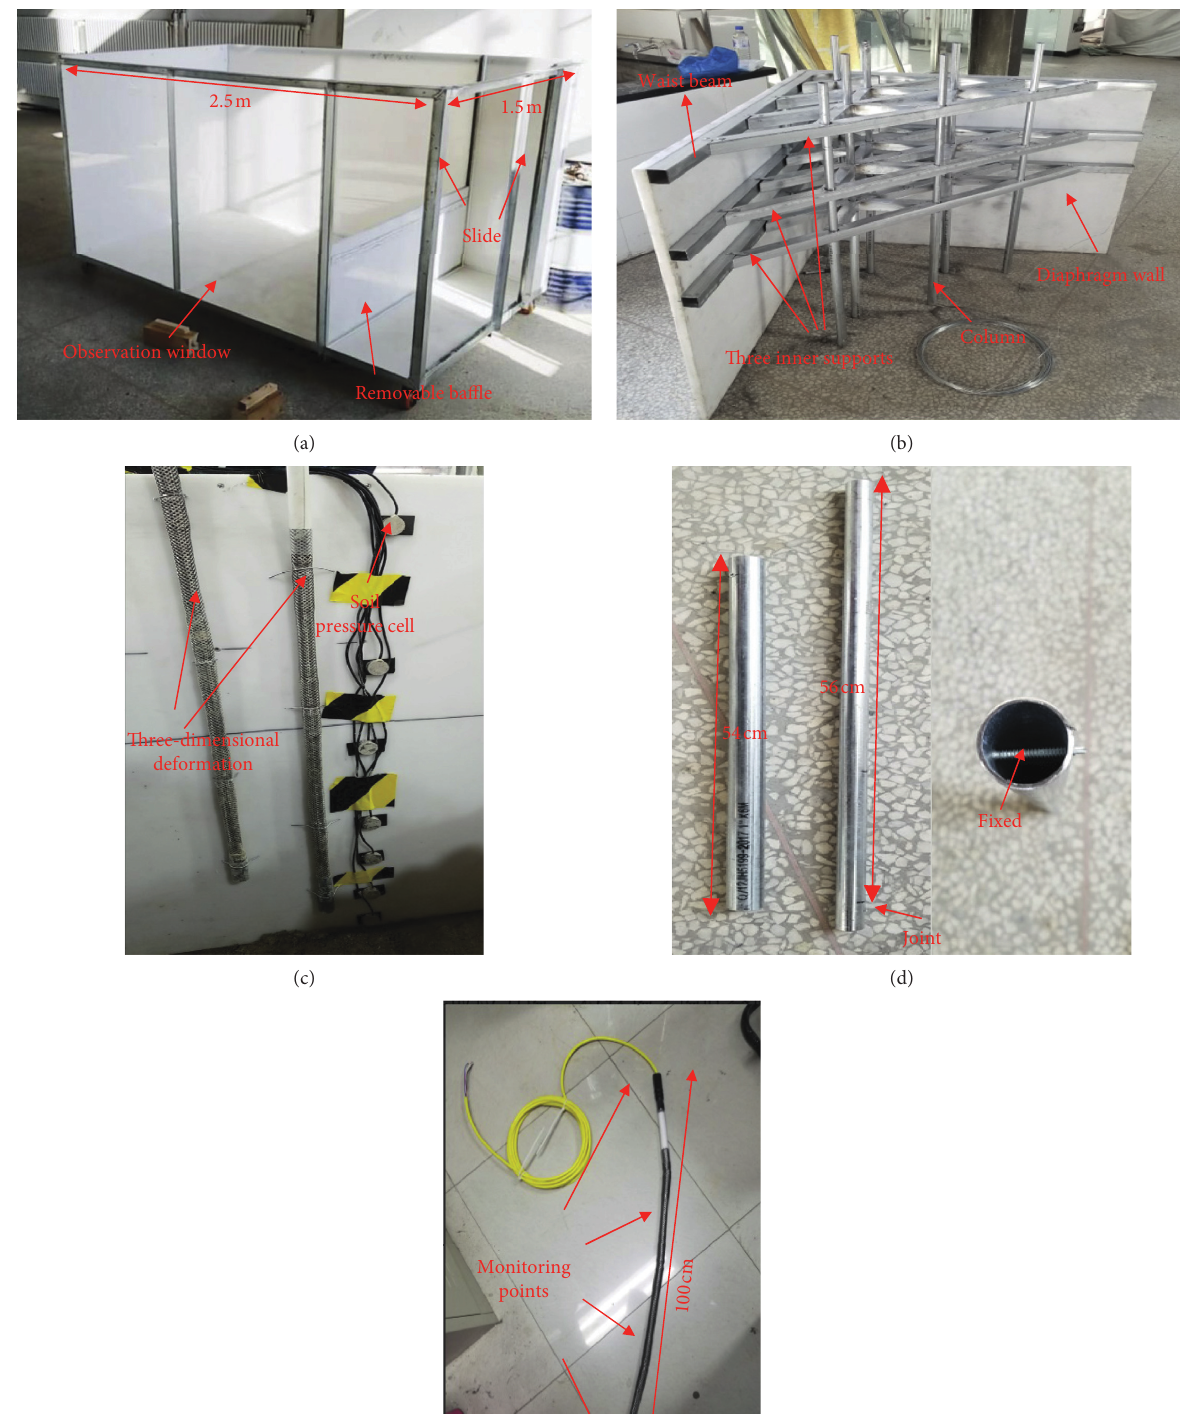
Figure 4: The preparatory work. (a) Model box. (b) Supporting structure. (c) Monitoring equipment. (d) Diagram of the column. (e) Displacement